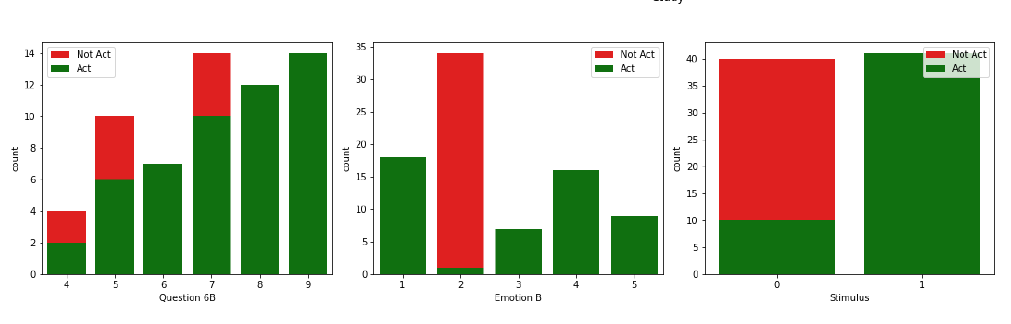
Figure 7. Frequencies of